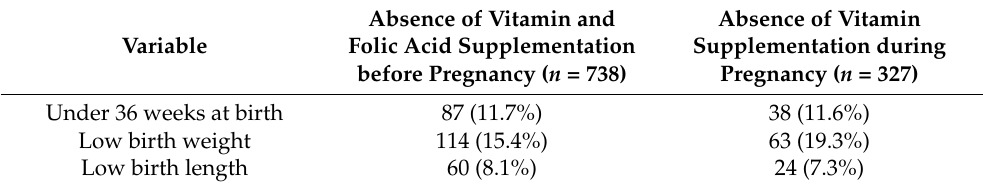
Table 6. Relationship between vitamin supplementation before and during pregnancy and parameters related to getting pregnant, pregnancy evolution, and birth outcomes.